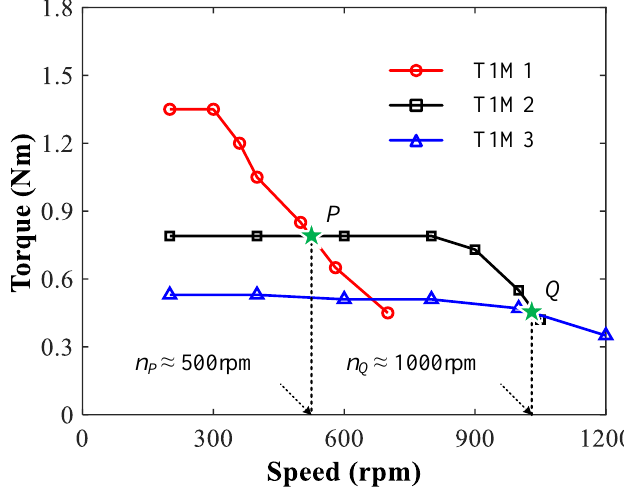
( b ) Figure 9. Measured no-load back-EMF of the investigated DS-PMM in three operating modes with different WS circuit. ( a ) Type I. ( b ) Type II. Since the two types of WS circuits had similar FW performance and the output torque of the prototype at T2M3 was too small to measure, the type I WS circuit was utilized to implement the WS strategy in the experimental validation. Figure 10 shows the measured torque – speed curves of the DS-PMM prototype in three operating modes with the type I WS circuit. The machine in T1M1 provided the largest output torque but its speed range was limited. As the machine was switched to T1M2, the out torque reduced, while the speed range extended. Additionally, the maximum speed could be achieved when the machine was switched to T1M3. On the other hand, the torque – speed curves intersected